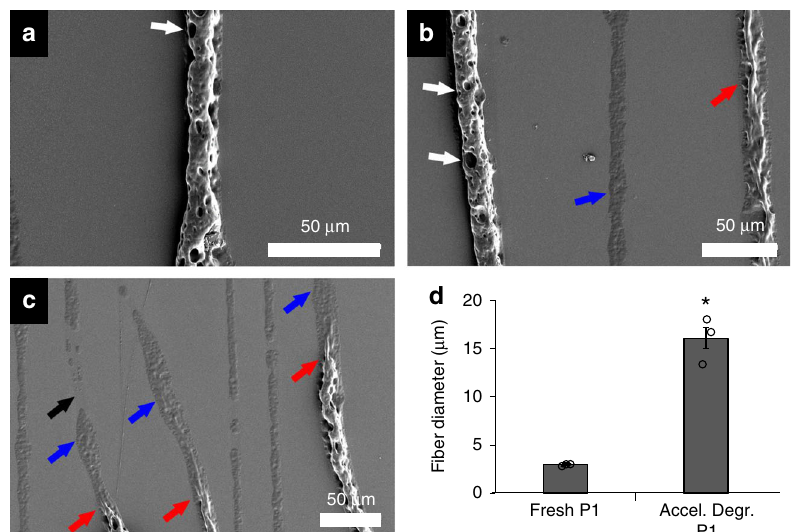
Fig. 6 Accelerated P1 fi ber degradation mechanism in water at 80 °C. a – c After 2 days of degradation at 80 °C electrospun P1 fi bers exhibited signi fi cant morphological changes that suggest bulk erosion. White arrows indicate pitting erosion. Red arrows indicate fi bers in late-stage degradation where fi bers develop a de fl ated appearance. Blue arrows indicate fi bers near end-stage degradation where a distinct fi ber no longer persists, but P1 residue remains. Black arrow indicates an area where a P1 fi ber and its remaining residue have completely degraded. d A large increase in fi ber diameter during the pitting erosion stage further suggests bulk erosion. ( n = 3, all values are mean ± std. dev., * p <0.05 via Tukey ’ s HSD, all SEM scale bars are 50 µ